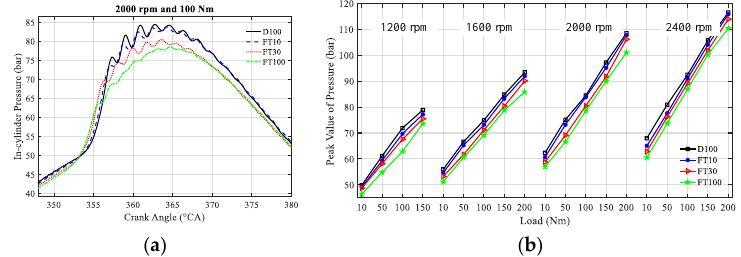
Figure 2. ( a ) the combustion pressure curves of all fuel under the condition of 2000 rpm and 100 Nm. ( b ) the pressure peak value of all fuels under all test conditions.